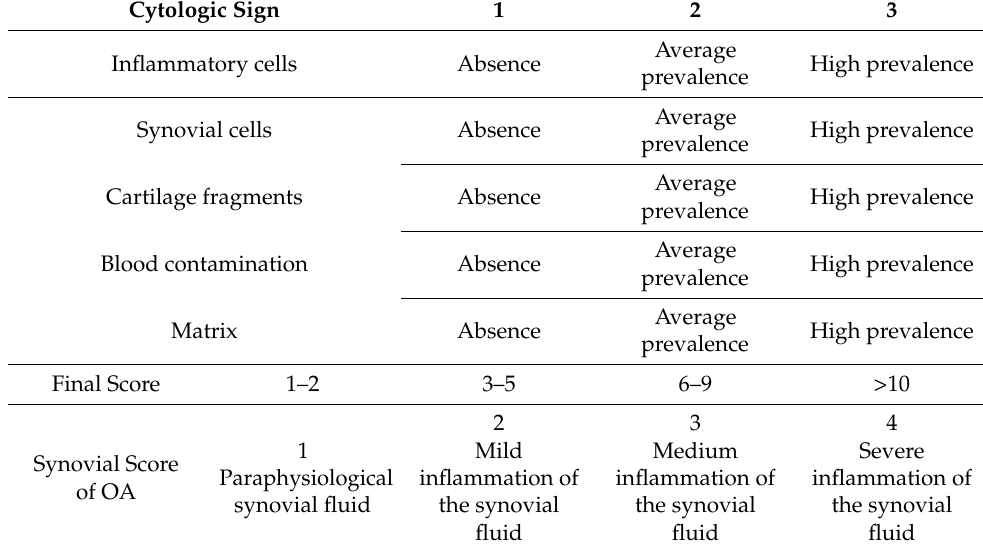
Table 4. Cytological score for synovial fluid evaluation in dogs with